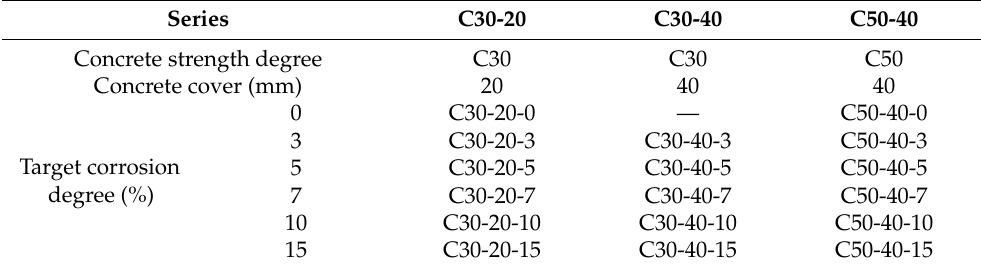
Table 1. Specimen